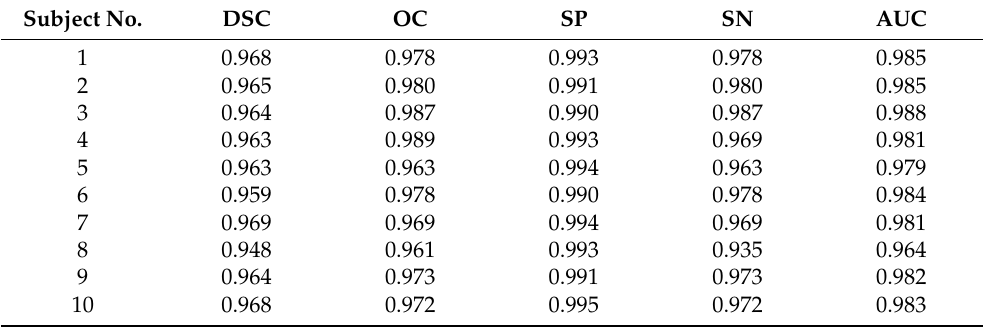
Table A6. Evaluation results for whole cerebellum segmentation, without fissures (model M3) on DLBS dataset.